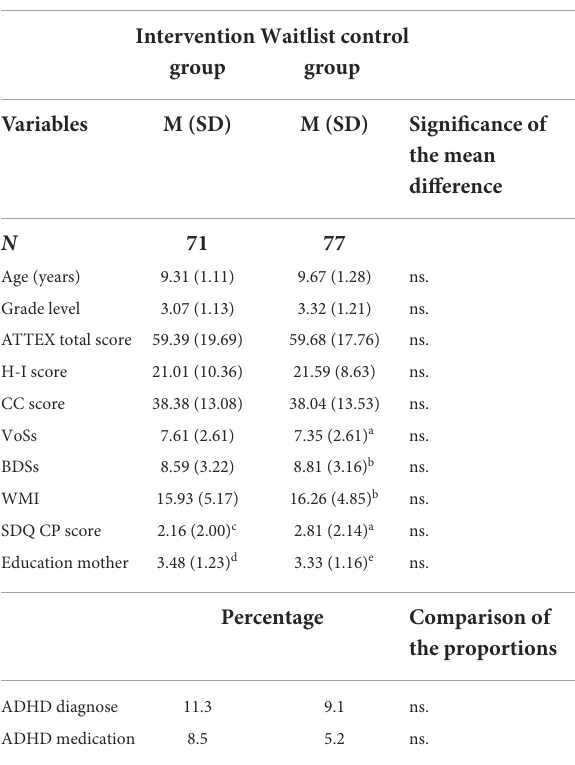
TABLE 2 Comparison of the baseline descriptive values between the intervention and waitlist